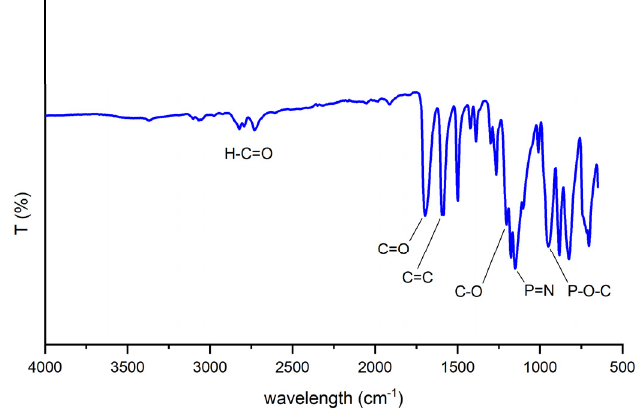
Polymers 2023 , 15 , x FOR PEER REVIEW Figure 2. FT-IR spectrum of compound 3 . Figure 2. FT-IR spectrum of compound 3 . Figure 2. FT-IR spectrum of compound 3 .